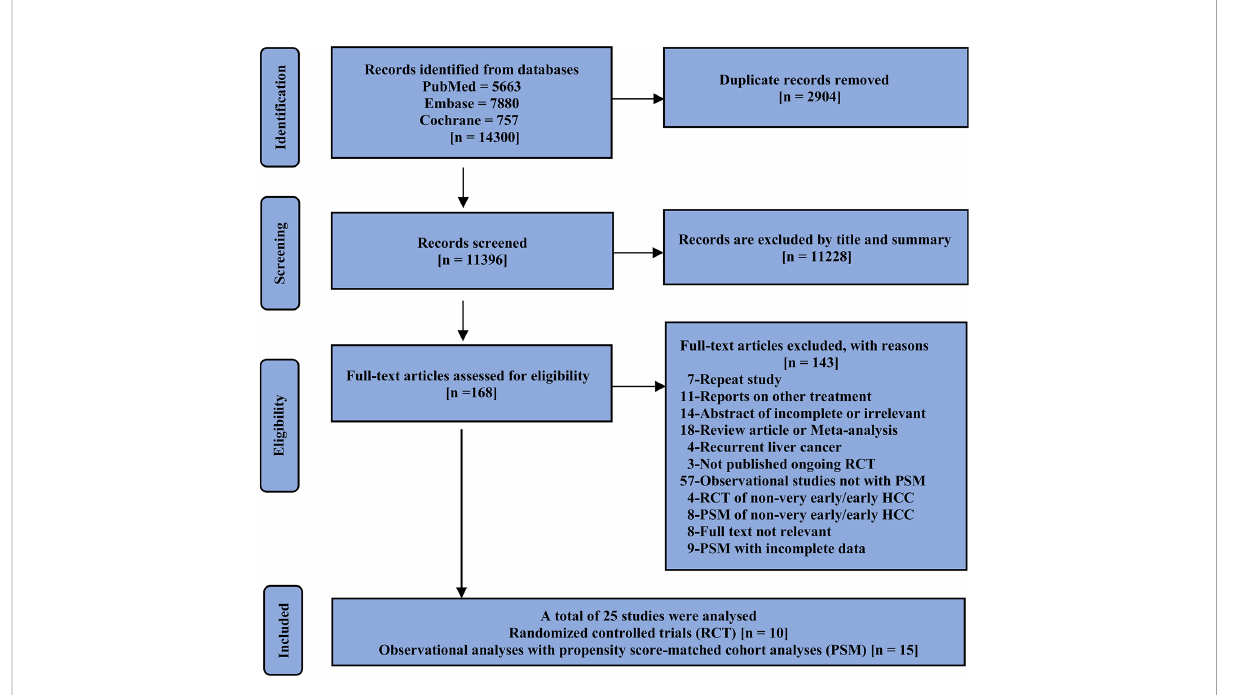
FIGURE 1 Flow chart showing the selection of